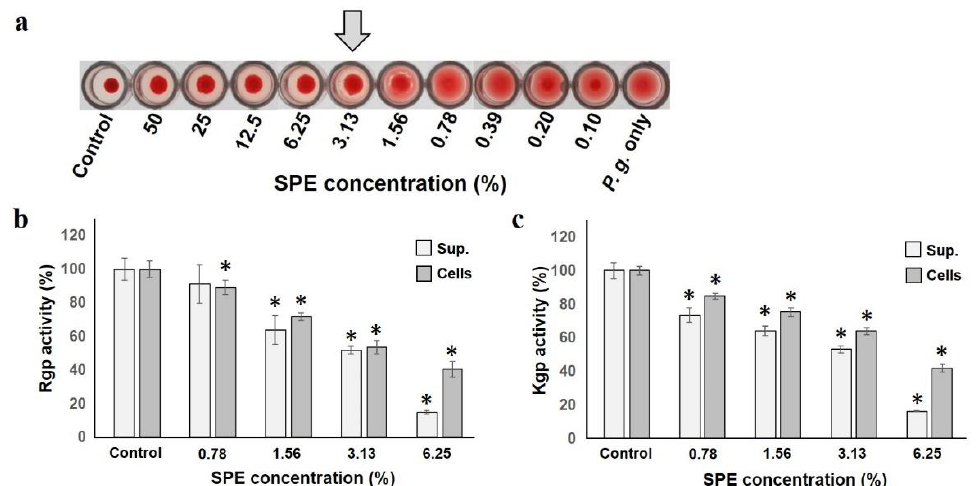
Figure 4. SPE is detrimental to hemagglutination and gingipain activities of P. gingivalis . ( a ): Effect of SPE on P. gingivalis hemagglutination. The arrow indicates the concentration at which hemagglutination inhibition occurs. ( b ): Rgp gingipain activity in culture supernatant or cells is shown as a ratio to that with 100% control. ( c ): Kgp gingipain activity in culture supernatant or cells. Each sample ( n = 6) indicated the statistical significance of difference between control and treated samples, determined using one-way ANOVA with Scheffe’s test (* p <